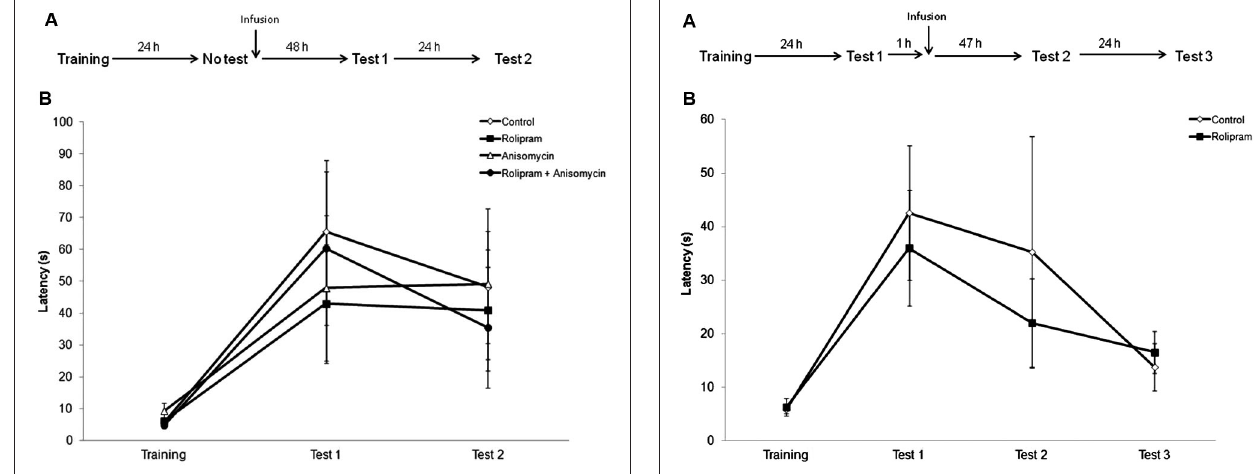
FIGURE 2 | No retrieval control . Rats were trained in IA and 24 h later received an intrahippocampal infusion of vehicle ( N = 13), rolipram (7.5 µ g/side, N = 12), anisomycin (80.0 µ g/side N = 7), or anisomycin plus rolipram ( N = 9), in the absence of a retrieval session. Retention test trials were carried out at both 48 (Test 1) and 72 h (Test 2) after infusion. (A) Schematic diagram showing the experimental design. (B) Latencies to step-down during IA behavioral trials. There were no significant differences among groups.